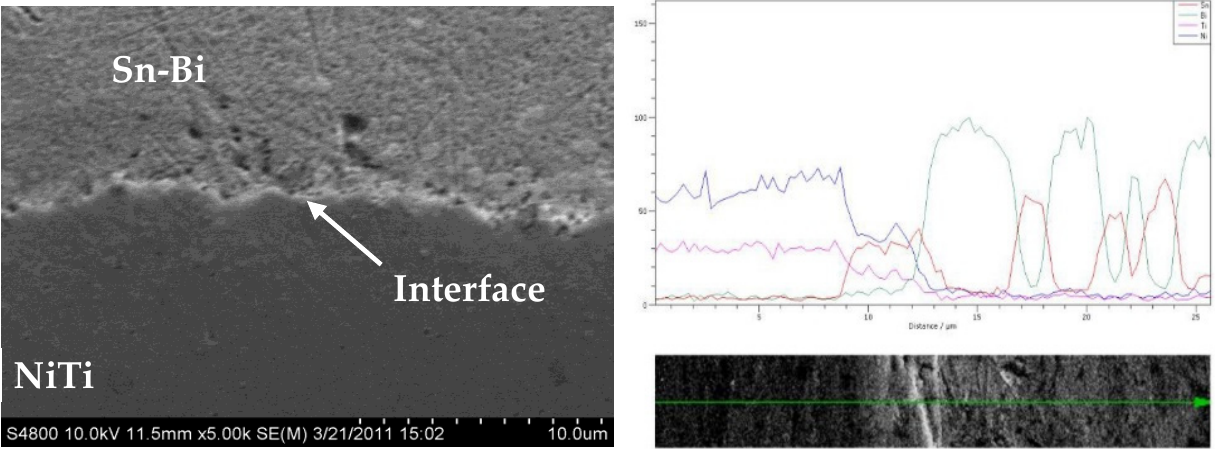
Figure 2. SEM image of Sn-20% Bi with a NiTi reinforcement (d = 500 µm) at ( a ) 300× and at ( b ) 1000× magnification. Reprinted/adapted with permission from Ref. [20]. 2013, Shobhit Misra.